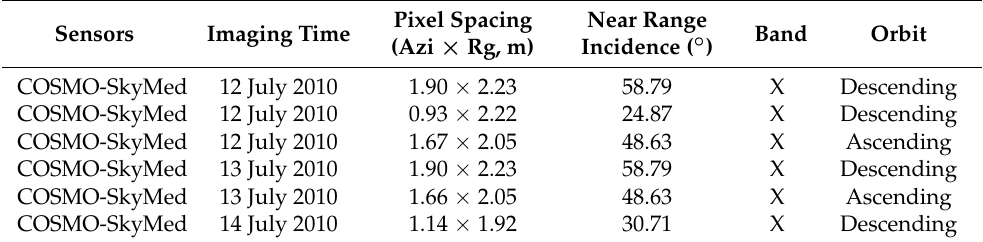
Table 1. Experimental SAR images